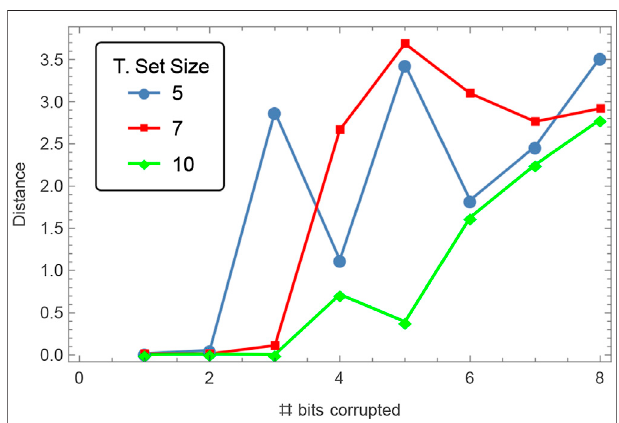
FIGURE 5 | The average Euclidean distance between the solution inferred by algorithmic optimization and the hidden parameters of the ODE in Section 6.1 when a number of bits of the binary representation of the labeled data has been randomly corrupted ( fl ipped), from 1 to 8 bits. The binary representationofthestates z 1 and z 2 hasanaccuracyof8bitseach,or16bits for the pair. At the maximum corruption level, 50% of the bits that represent a pair of outputs in the sample set are being fl ipped, destroying any kind of information within each sample. The average was taken from ten random sample sets of size 5, 7, and 10. Each set was computed by randomly selecting times t between 0 and 1 in intervals of size 0.05, then corrupting the correspondingoutputbythespeci fi ednumberofbits( y axis).Fromtheresults it can be seen that algorithmic optimization is resilient up to corruptions of 4 – 5 bits, or > 25% percent of the data, even when using relatively small training data sets.